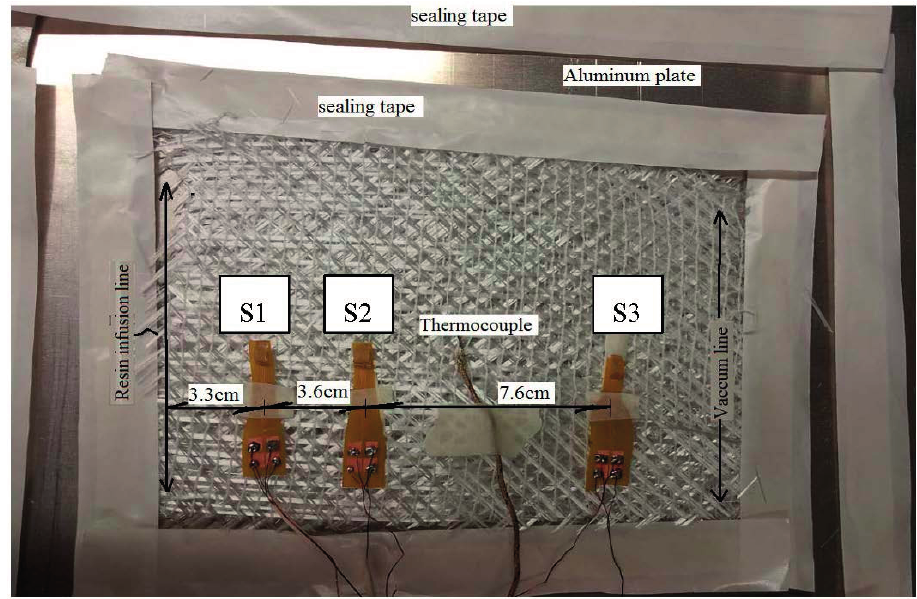
Figure 7. Embedding of three PPSs mounted on flexible board in the glass fiber